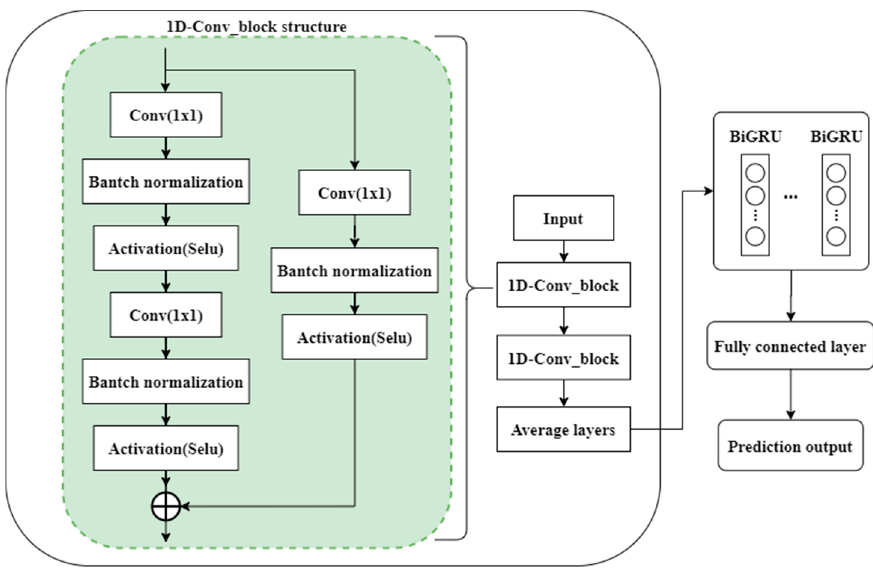
Figure 4. The network structure of water quality